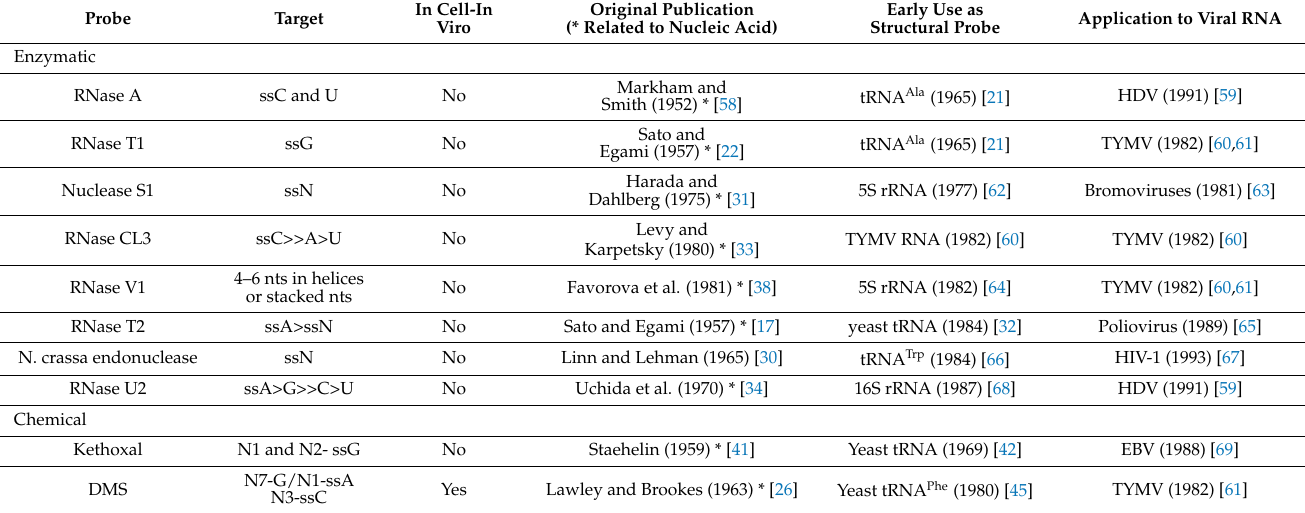
Table 1. Enzymatic and chemical probes from 1965 to 2005. Abbreviations are as follows: A: adenosine; G: guanosine; C: cytidine; U: uracil; N: any nucleotide; ssN: any unpaired nucleotide, regardless of the base; ssA (G, C, or U): unpaired adenosine (guanosine, cytidine, or uracil); dsN: any paired nucleotide; HDV: hepatitis D virus; TYMV: turnip yellow mosaic virus; HIV-1/2: human immunodeficiency virus type 1/2; EBV: Epstein–Barr virus; • OH: hydroxyl radical. * indicate the publications that concern nucleic